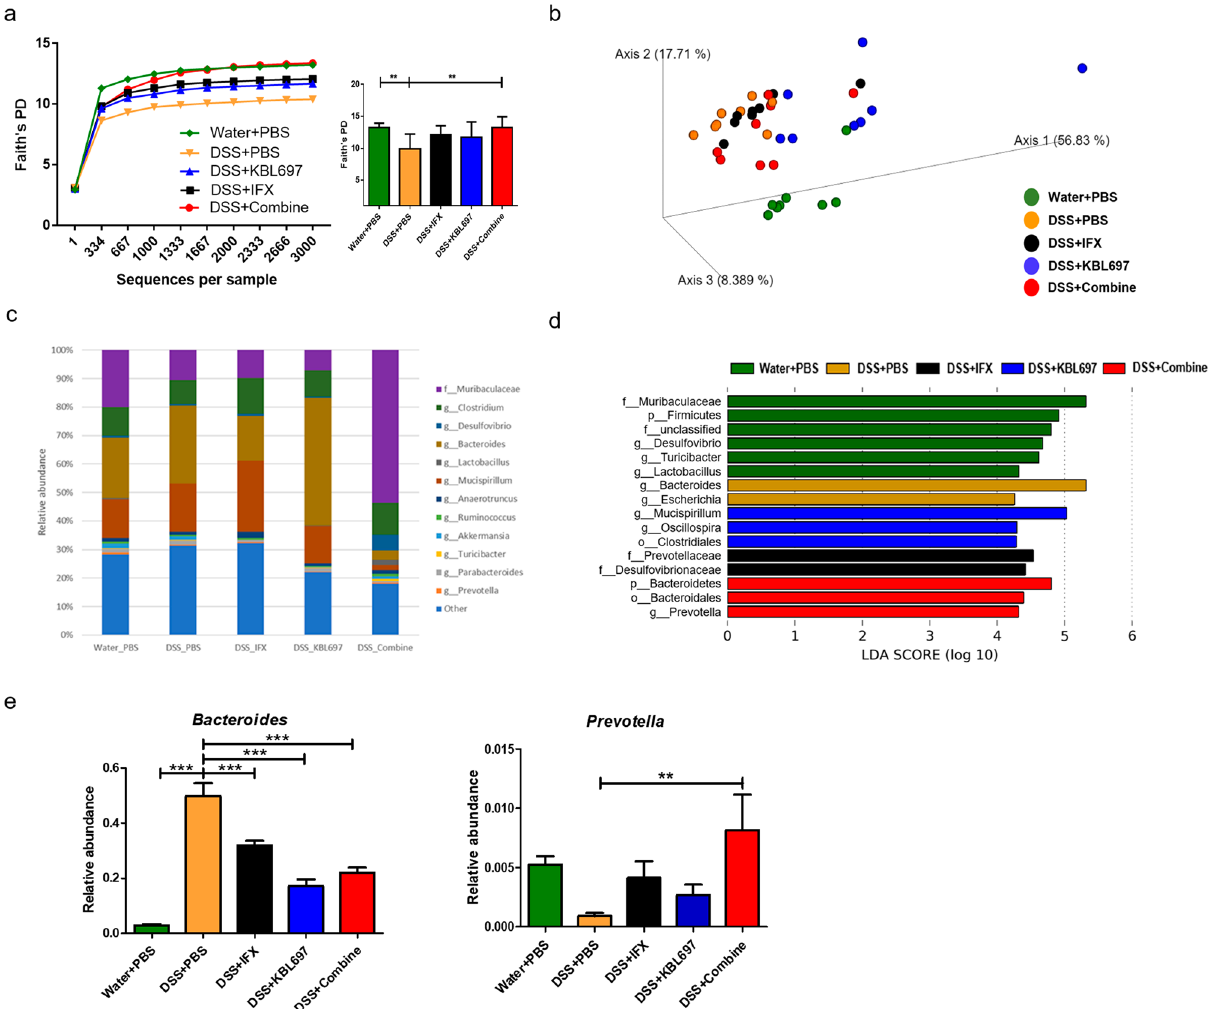
Figure 5. Effect of the different treatments on cecal microbiota composition. ( a ) Rarefaction plots using Faith’s phylogenetic diversity (PD) whole tree indices. ( b ) Principal coordinates analysis with unweighted UniFrac distances. ( c ) Taxonomic structures of cecal microbiota. ( d ) LEfSe results in experimental groups (threshold > 2.5). ( e ) Relative abundances of significantly different microbial taxa in experimental groups at the genus level. When appropriate, statistical analysis was performed using one-way ANOVA with Dunnett’s post hoc test (* P < 0.05; ** P < 0.01; *** P <